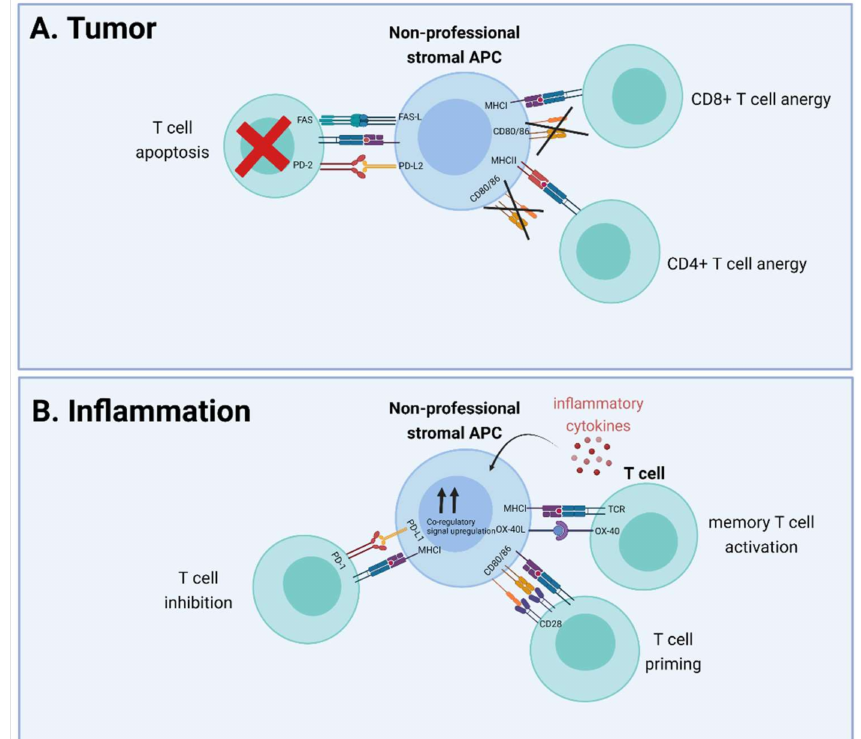
Figure 2. Effect of nonprofessional stromal APC antigen presentation on T cell function in tumor and inflammatory conditions. ( A ) CAFs reside in the tumor micro-environment, cross-present ex- ogenous antigen cells to CD8+ T cells, and delete them in a PD-L2- and FAS-L-dependent manner, or cause anergy in T cells after antigen presentation by either MHCI or MHCII due to the lack of co-stimulatory molecules. ( B ) Inflammation results in the release of inflammatory cytokines that can cause upregulation of co-stimulatory (CD80, CD86, OX-40L) or co-inhibitory (PD-L1) molecules. Pre- dominant upregulation of co-stimulatory signals enables T cell priming (CD28-CD80/86) interaction and memory T cell activation (OX-40L-OX-40) by nonprofessional stromal APCs, while upregulation of PD-L1 results in T cell inhibition. APC: antigen-presenting cell; PD-L: programmed death-ligand; TCR: T cell receptor; MHC: major histocompatibility complex; FASL: FAS